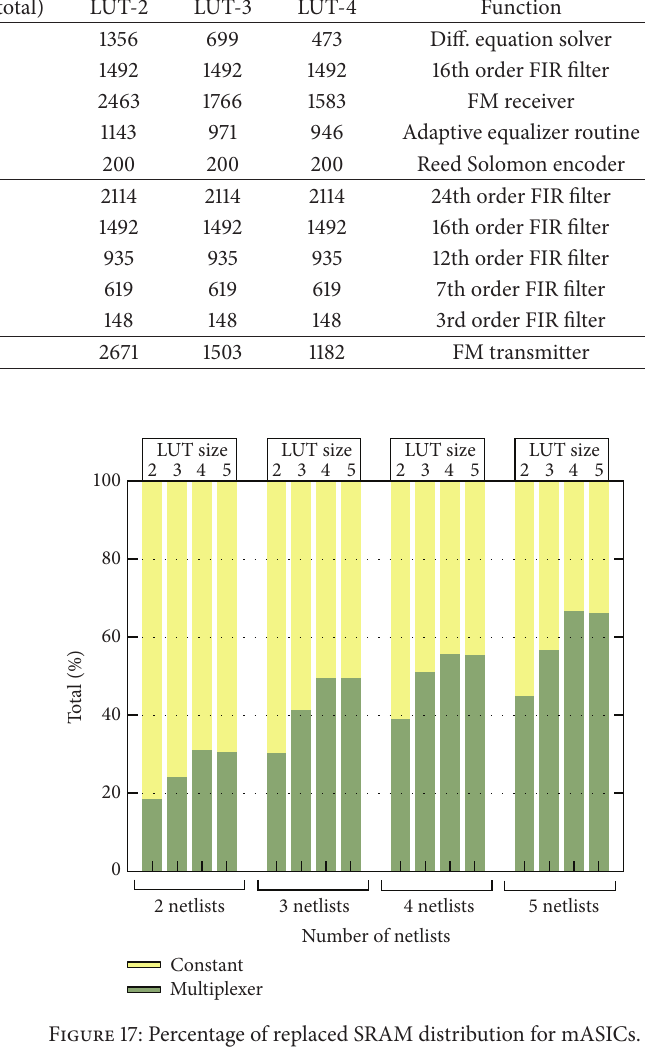
Figure 16: Synthesis methods used in this work.